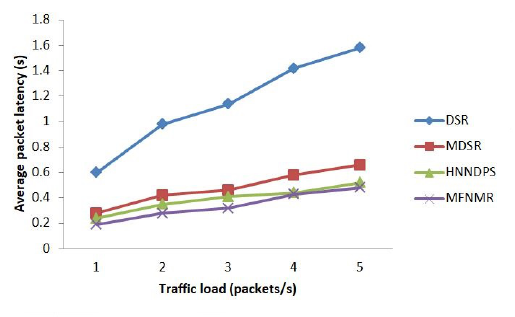
Figure 12. Average Packet Latency Analysis based on Network